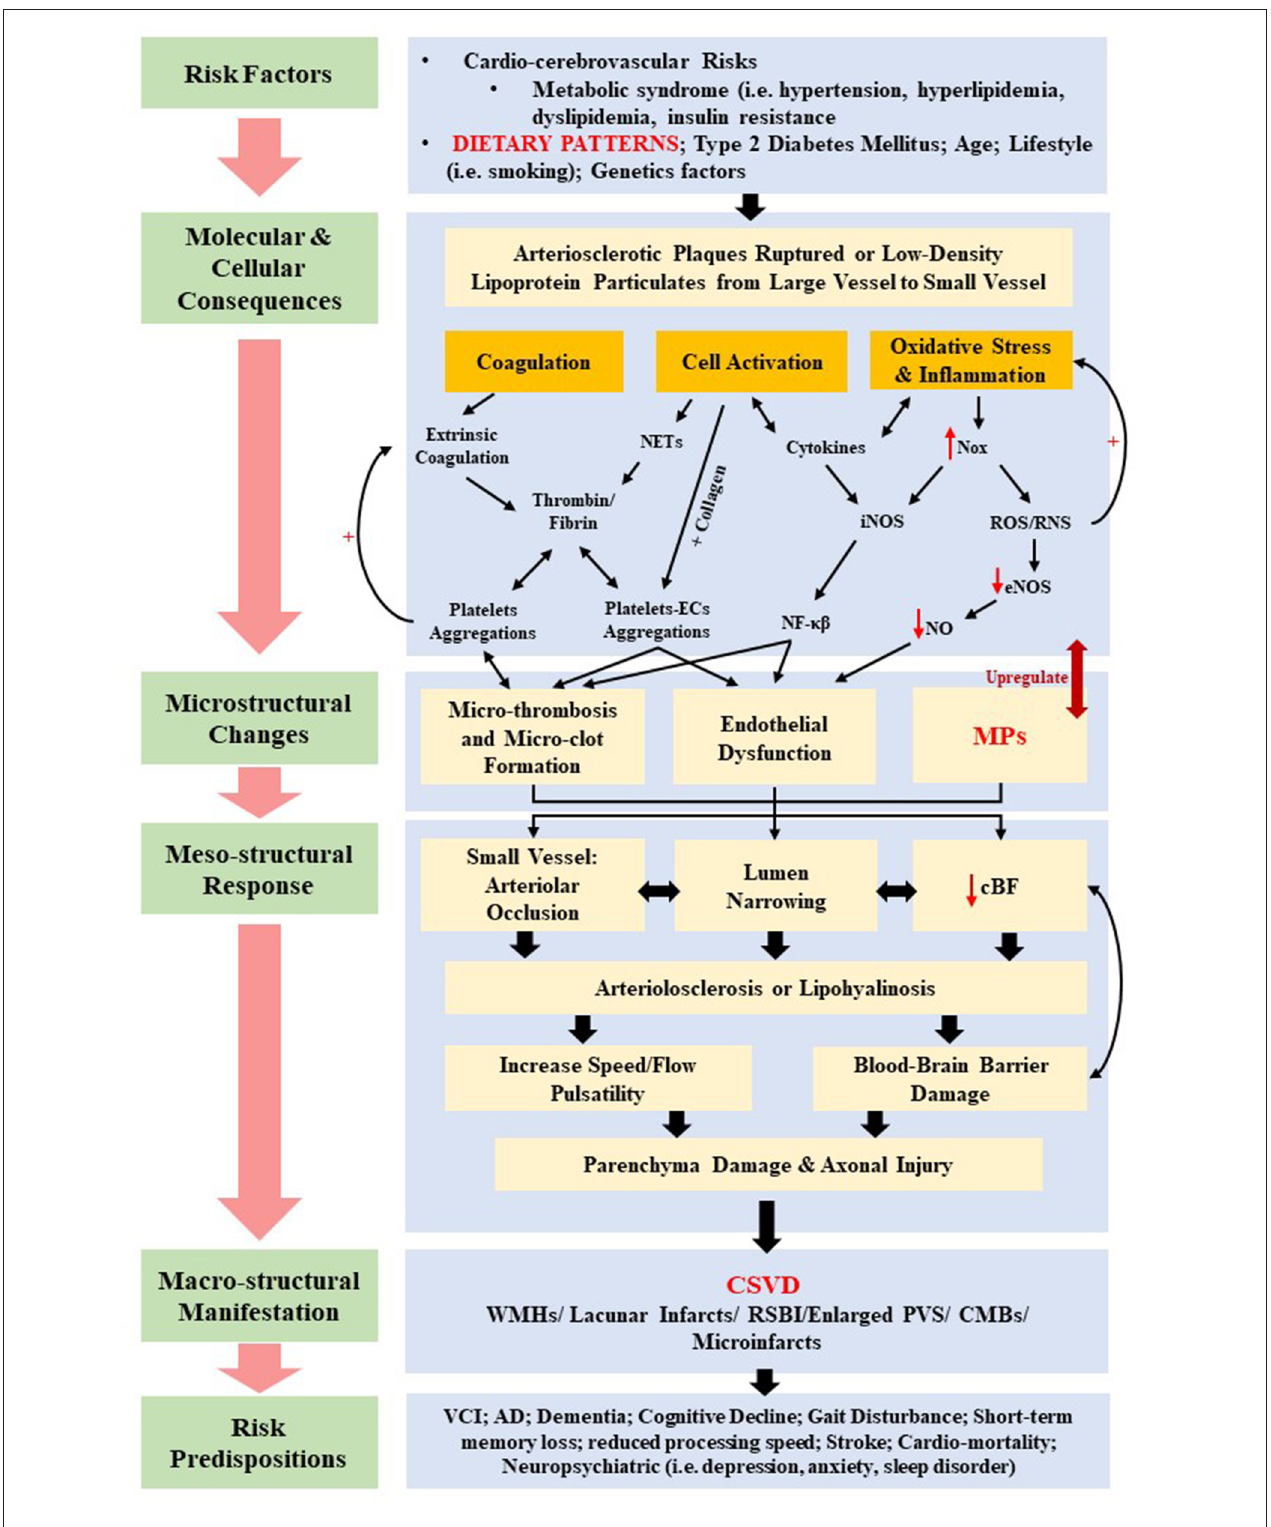
FIGURE 3 | Summary of the proposed overlapping pathomechanisms of cerebral small vessel disease (CSVD) through coagulation, cell activation, endothelial dysfunction, and inflammation. cBF, cerebral blood flow; CMBs, cerebral microbleeds; ECs, endothelial cells; eNOS, uncoupled endothelial nitric oxide; iNOS, inducible nitric oxide synthase; MPs, microparticles; NETs, neutrophil extracellular traps; NF- κβ , nuclear factor κβ ; NO, nitric oxide; Nox, nitric oxide synthase oxidase; ROS, reactive oxygen species; RNS, reactive nitrogen species; RSBI, recent subcortical brain infarcts; PVS, periventricular spaces; WMHs, white matter hyperintensities.